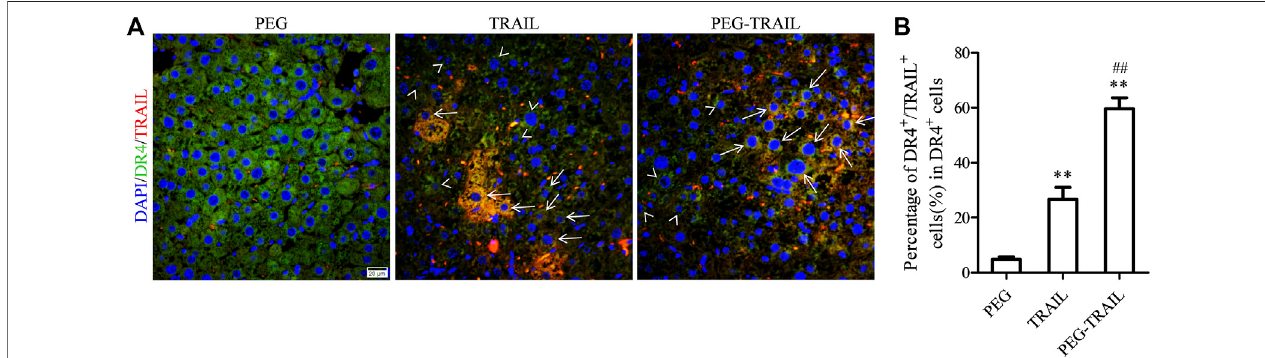
FIGURE 5 | PEG-TRAIL enhances the long-circulating ef fi ciency of TRAIL in hepatic fi brosis mice models. (A) TRAIL/TRAIL-R1 double-labeling IF of the livers after treatment with PEG, TRAIL, or PEG-TRAIL. (B) A histogram showing the percentage of DR4 + /TRAIL + cells in DR4 + cells in liver tissues after treatment with PEG, TRAIL, or PEG-TRAIL. ** p < 0.01, compared with PEG; ## p < 0.01, compared with